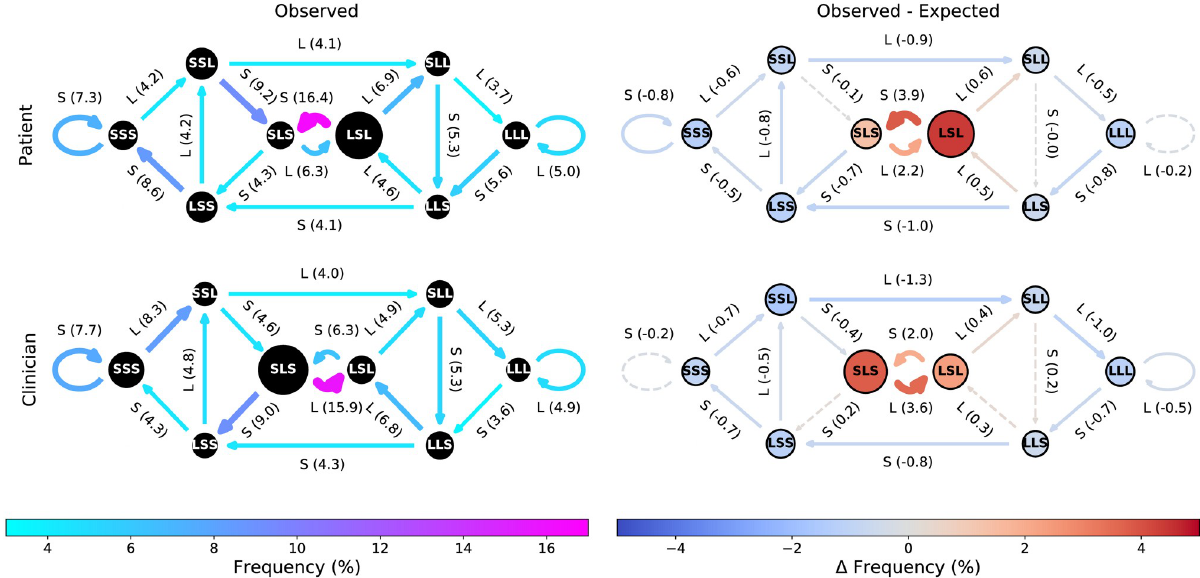
Fig 2. Normative patterns of information flow in the PCCRI corpus. (Left column) CODYMs of normative patterns of information flow for patient turns (top) and clinician turns (bottom), averaged over the 117 PCCRI conversations analyzed (% Observed ). (Right column) Difference CODYMS, where Δ Frequency = (% Observed ) − (% Expected ), for both patient turns (top) and clinician turns (bottom). In the difference CODYMs, state and transition frequencies where observed values are statistically significantly different from expected values ( P < 0.05, by empirically determined 95% confidence intervals for the null models) are indicated by outlining states in black solid ( vs . dashed) circles and drawing transition arrows with solid ( vs . dashed) lines.